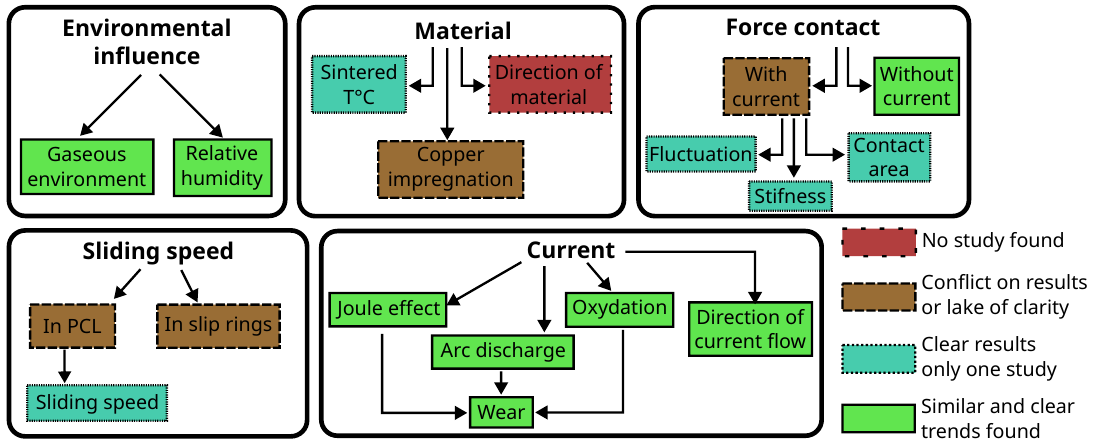
Figure 12. Overview of the numerous fields of study focusing on sliding electrical contacts, their progress, and lack of